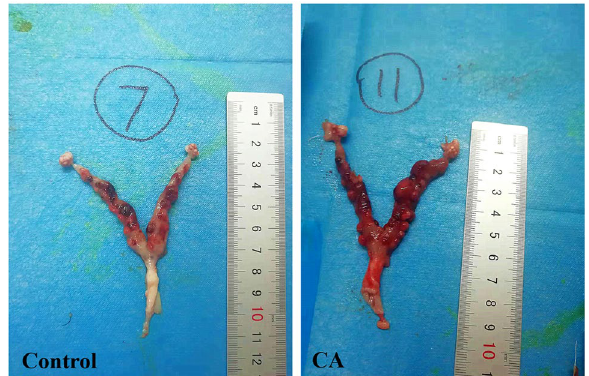
Figure 1. General appearance of uterine specimens on day 3 after Candida albicans (CA) injection into the reproductive tract of rats (right) compared with the control group (left). CA, Candida albicans group.